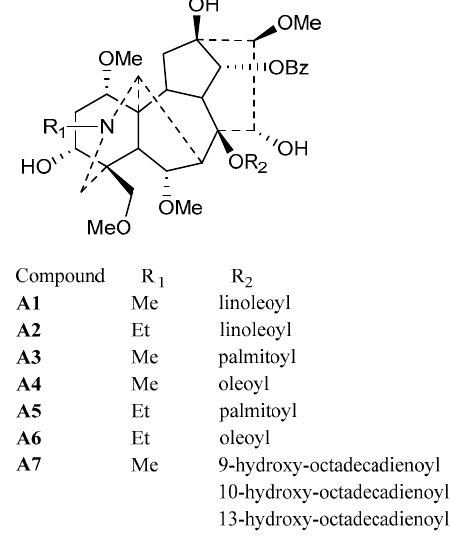
Figure 2. LC-MS chromatogram ( A ) and MS/MS spectra ( B ) of fatty acids released by alkaline hydrolysis.